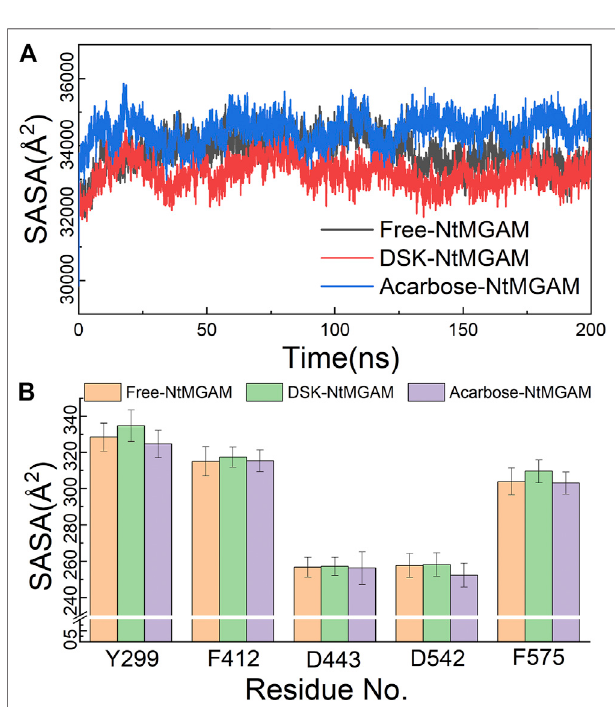
FIGURE3 |(A) Solvent-accessiblesurface area(SASA)analysisofthree systems over 200 ns MD. (B) SASA of active residues in different compound